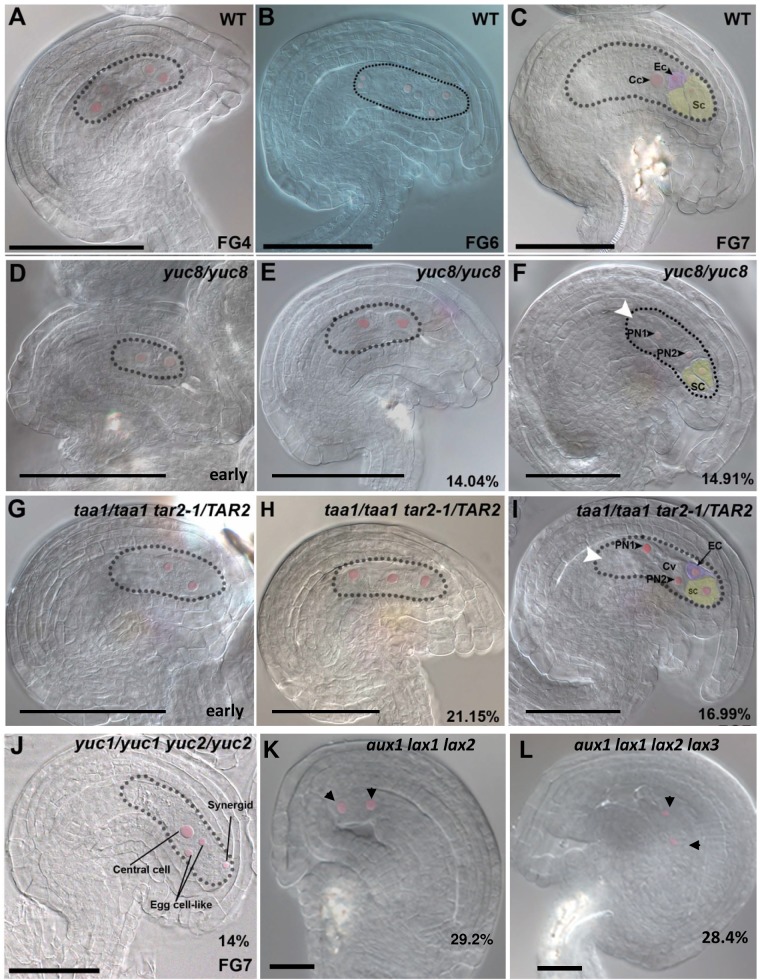
Embryo sac developmental defects in mutants impaired in auxin biosynthesis and import.
A-C, WT; D-F,
yuc8/yuc8; G-I,
taa1/taa1 tar2/TAR2; J,
yuc1/yuc1 yuc2/yuc2; aux1 lax1 lax2; K, aux1 lax1 lax2 lax3. A, WT 4-nucleate embryo sac at FG4 stage. B, WT 8-nucleate embryo sac prior to cellularization. C, WT mature 4-celled embryo sac yuc8 mutant embryo sac at FG7 stage showing defects in polar nucleus migration. D,
yuc8 mutant gametophyte at FG4 stage containing only 2 nuclei. A comparable WT gametophyte will typically carry 2 nuclei at this stage. E,
yuc8 mutant ovule at FG5 stage with a 2-nucleate arrested embryo sac. F, Mature yuc8mutant embryo sac showing defective polar nucleus migration, no antipodals are visible at this stage. G, A mutant ovule, with only 2 nuclei in the coenocytic embryo sac. H, Mutant ovule with 3-nucleate gametophyte. Unlike clearly polarized nuclei in the WT, these nuclei are scattered in the cytoplasm. I, Mature mutant embryo sac showing defective polar nucleus migration, antipodals are completely degenerated by this stage. J, A yuc1 yuc2 double mutant showing miss-polarized micropylar nuclei, giving rise 2 egg cell-like structures instead of 1. K, Ovule from a triple mutant aux1 lax1 lax2 showing an embryo sac arrested at FG2 stage. The arrows point at the nuclei inside the embryo sac. L, Ovule from a quadruple mutant aux1 lax1 lax2 lax3 showing a collapsing embryo sac containing only two nuclei (arrows). Except for the phenotypes shown in panels D and G, all mutant phenotypes shown are terminal and observed at late stages of ovule development as indicated in Table 1 and in S1 Table. Cv, central vacuole; Ec, egg cell; PN1, polar nucleus 1; PN2, polar nucleus 2; Sc, synergid cell. Scale bar, 50 μM for A-J and 20 μM for K-L.